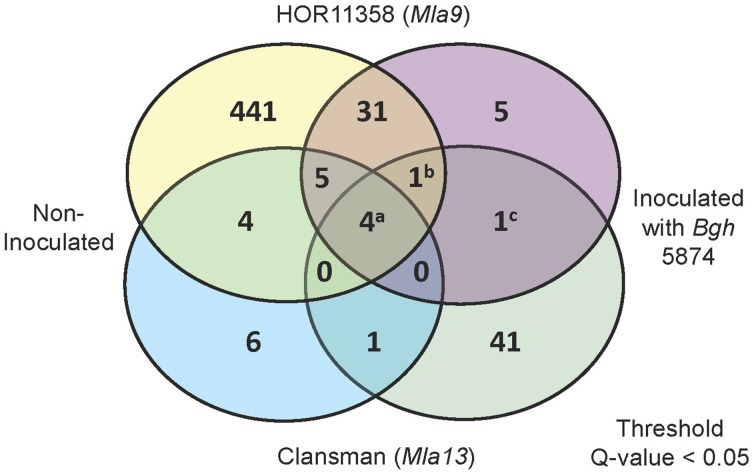
Summary of differentially expressed genes in
Bln1-silenced leaves as compared to BSMV:00 controls. Venn diagram represents differentially expressed genes (Threshold: q < 0.05) with and without inoculation with Bgh for both HOR11358 (Mla9; upper circles) and Clansman (Mla13; lower circles) background plants. Contrasts were assessed between empty vector (BSMV:00) and Bln1 silenced (BSMV:Bln1248) plants. Superscripts (a) Contig12608_at, HS16M03u_x_at, HV10C01u_s_at, Contig3615_at (Importin α-1b); (b) Contig12219_at (Bln1); (c) Contig3680_s_at (Sec61 γ).